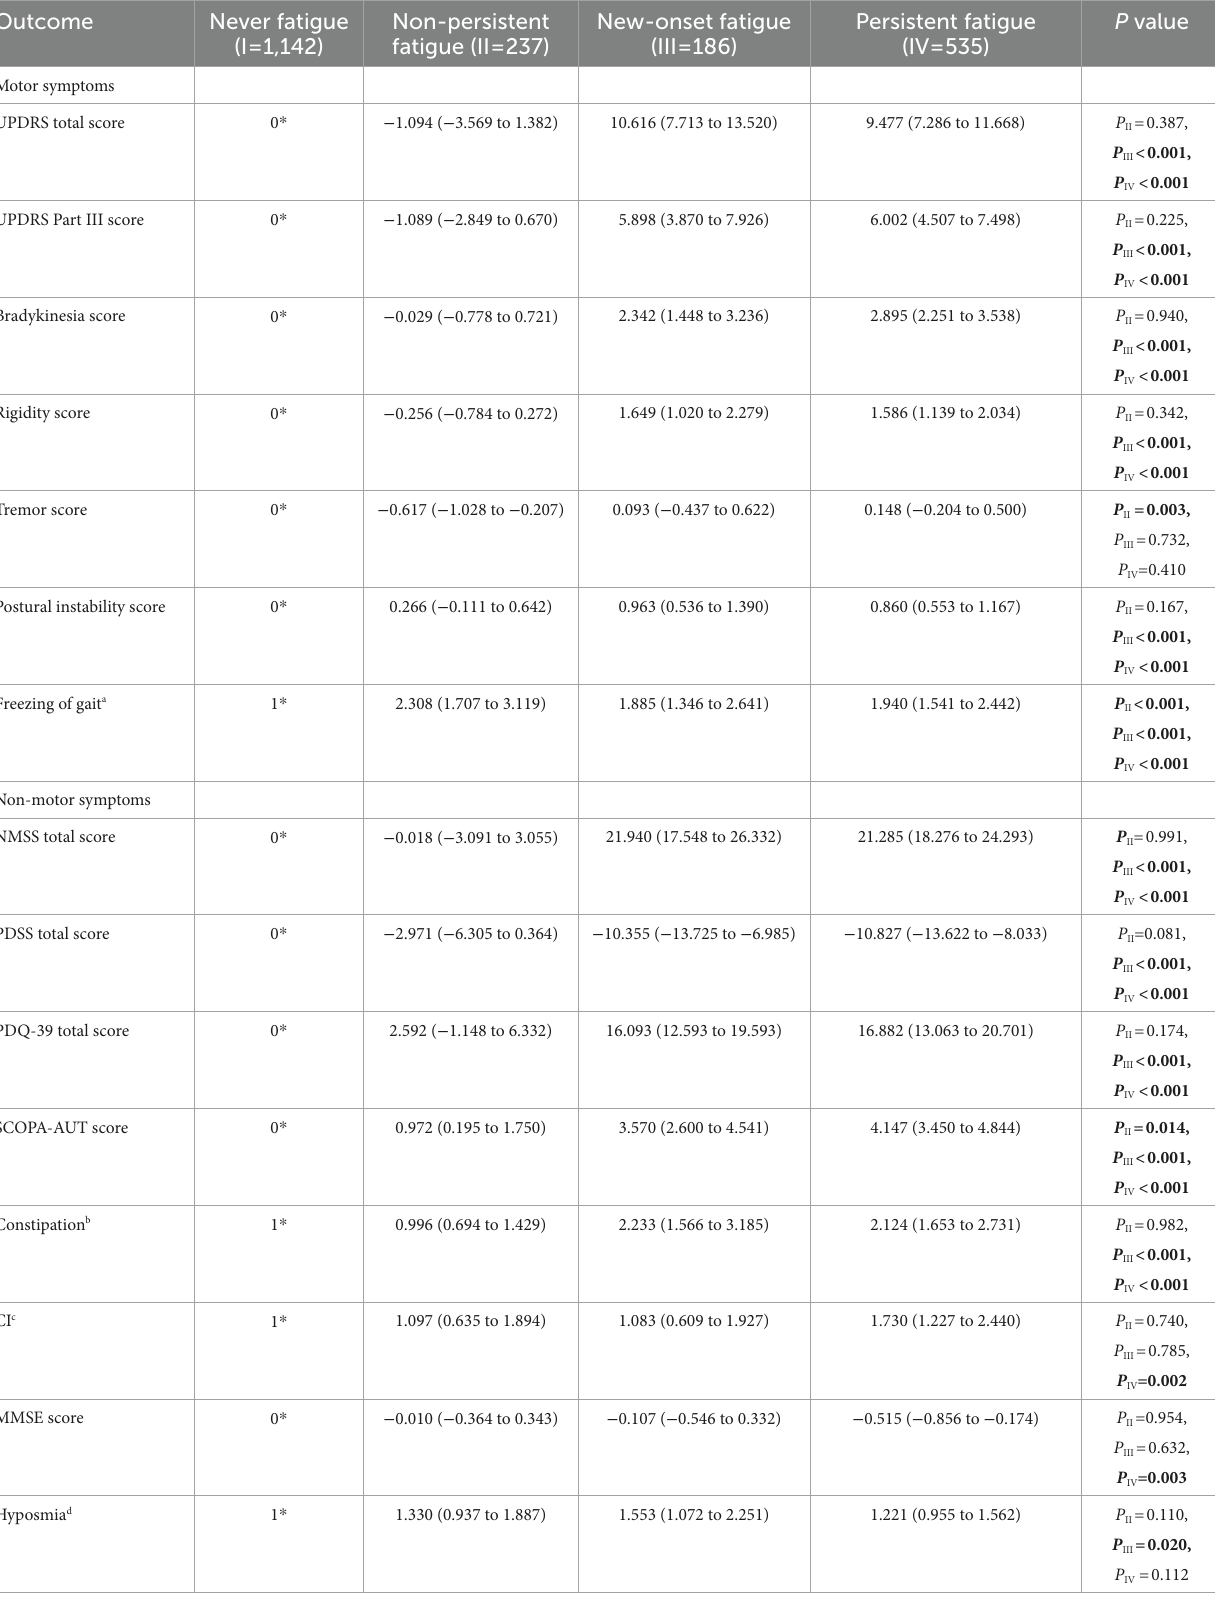
TABLE 4 Progression of motor and non-motor outcomes in four different fatigue subgroups. Outcome Never fatigue